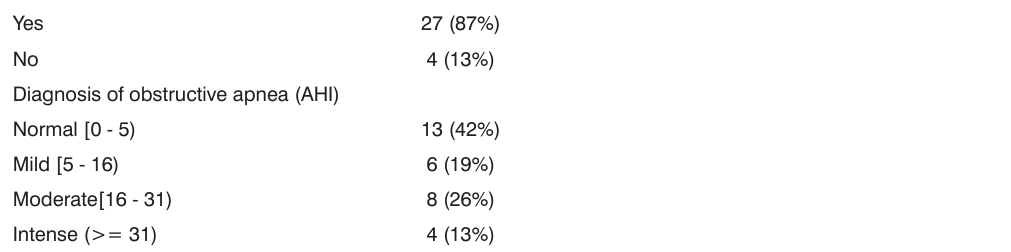
Table 2. Evaluation of the snore detector.